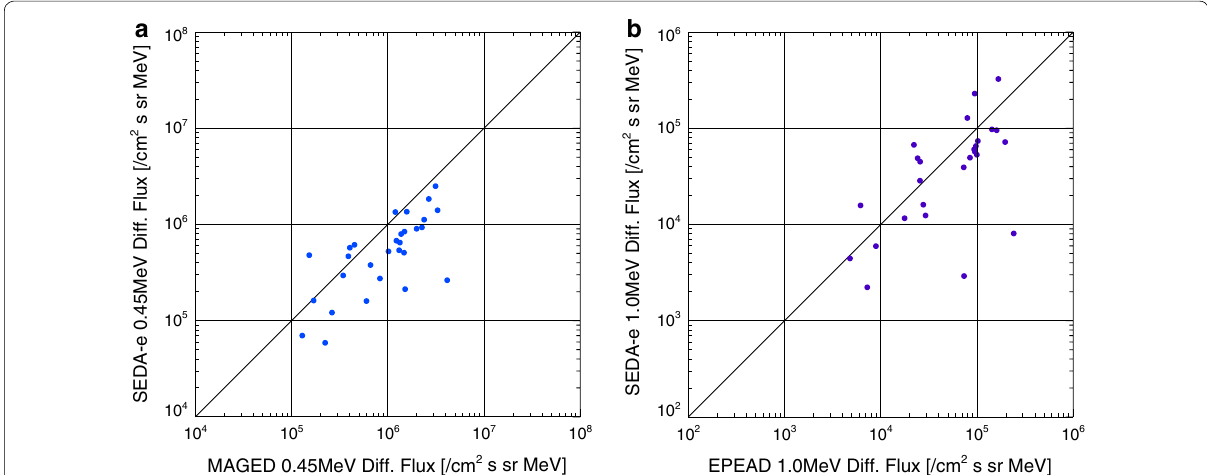
Fig. 6 a Scatter plot showing relationship between electron flux at 0.45 MeV estimated from SEDA-e and that estimated from MAGED. b Scatter plot showing relationship between electron flux at 1.0 MeV estimated from SEDA-e and that estimated from EPEAD